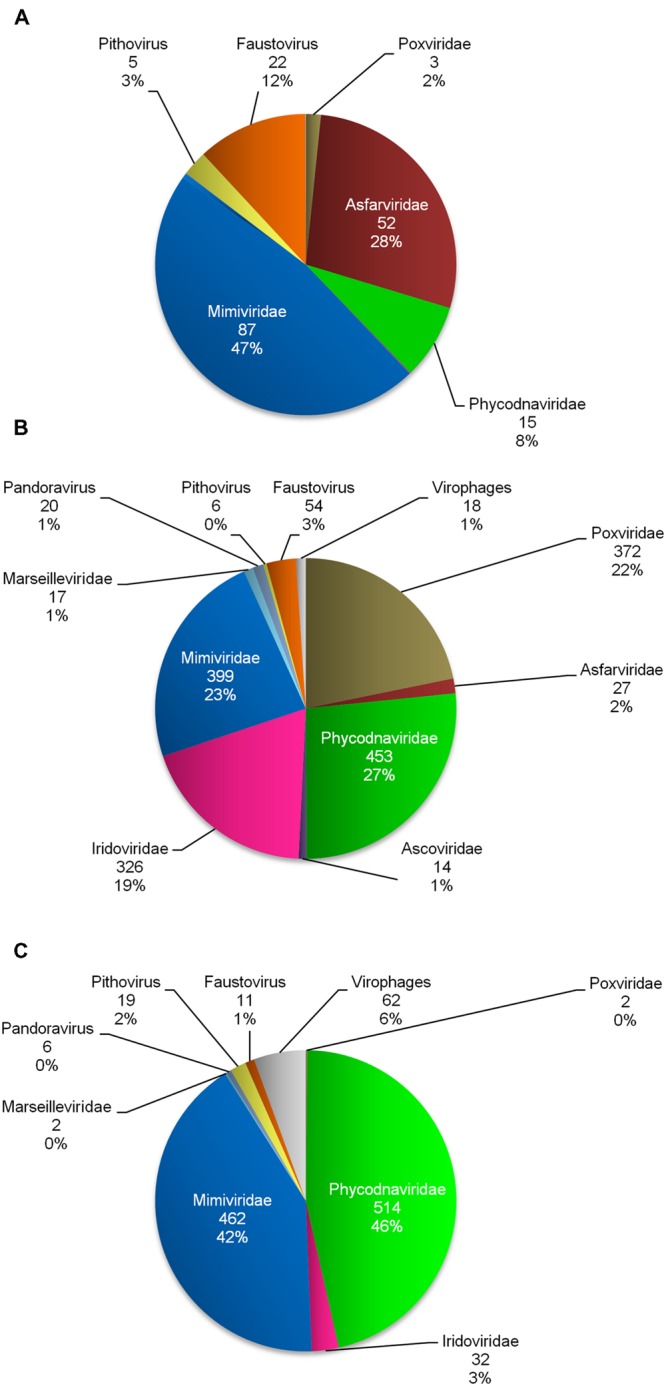
Distribution of Megavirales member- and virophage-related reads identified by MG-Digger in metagenomes generated from human sera and sewage (A; Loh et al., 2009), plasma from patients with liver diseases (B; Law et al., 2013) and water from the Indian Ocean (C; Williamson et al., 2012).